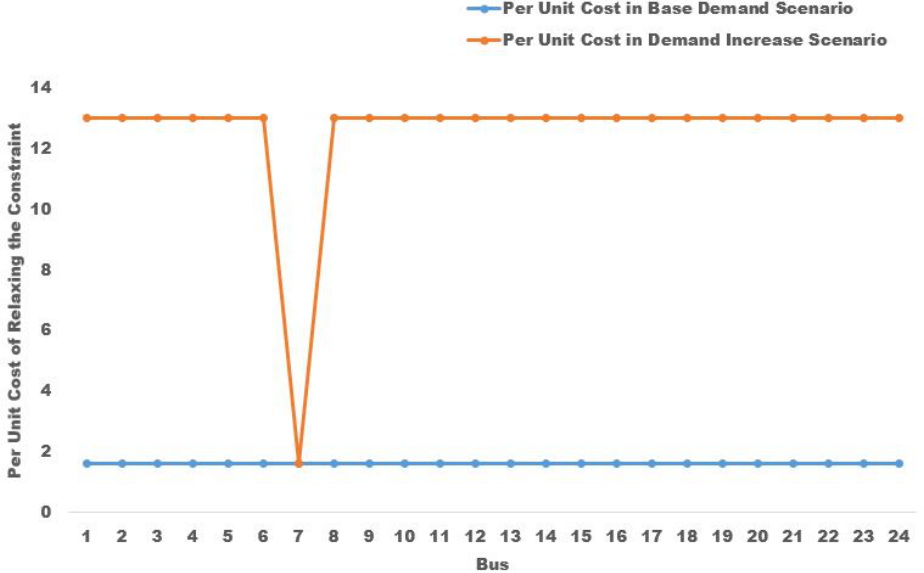
Figure 6. The per unit cost of relaxing the constraint in base and increased demand scenarios in a 24-bus